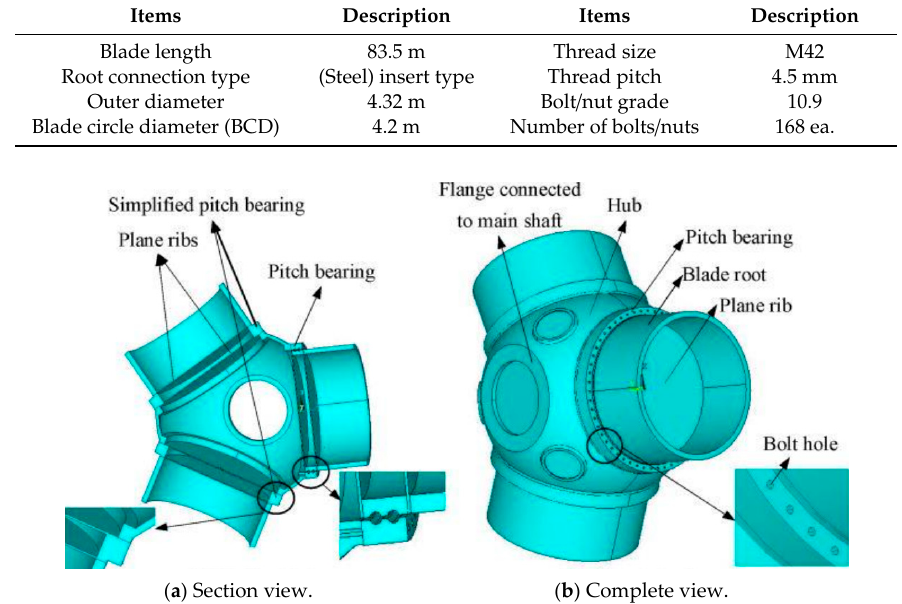
Figure 2. Overall component diagram consisting of a blade root connection [17].